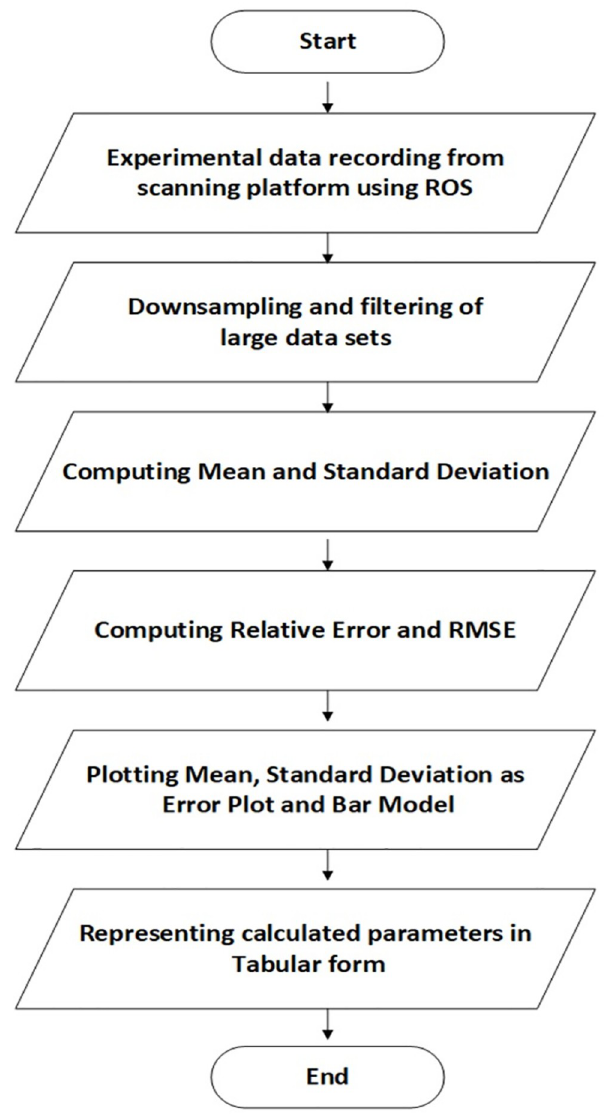
Fig 8. Flow chart of overall testing